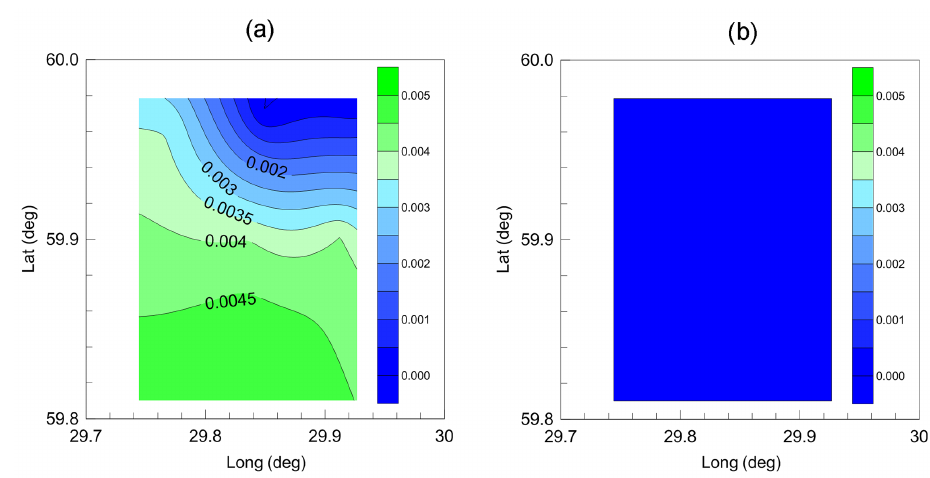
Figure A2. The map of the median LWP values (kgm − 2 , colour scale) calculated for the small terrain and for the WH (a) and CD (b) data sets (measurements by the SEVIRI